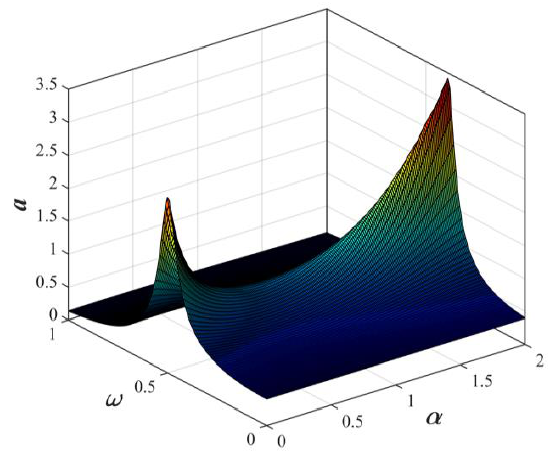
Figure 7. The three-dimensional curve of the amplitude and frequency characteristics of the GMA system.